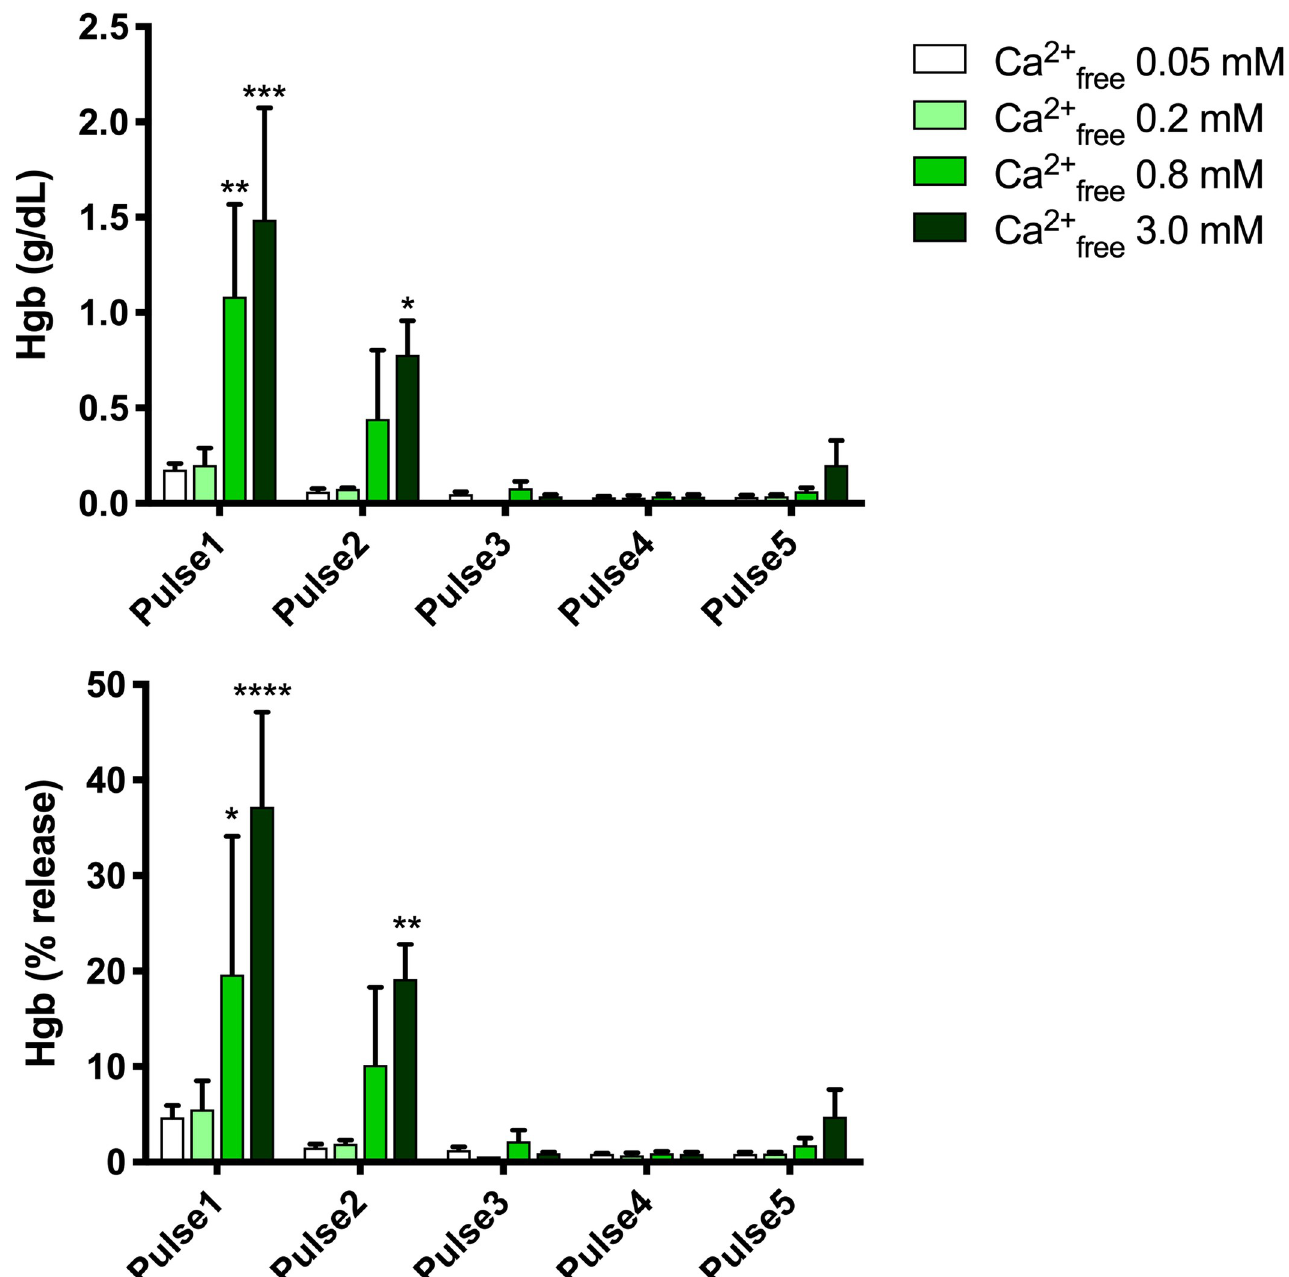
Fig 2. Hemoglobin in supernatants of electrical activated samples. Upper panel, g/dL, lower panel, % of total hemoglobin. Results are means ± SEM, n = 3. Asterisks indicate significant differences within each pulse treatment for 0.2, 0.8 and 3.0 mM Ca 2+ free vs. 0.05 Ca 2+ free . � p < 0.05, �� < 0.01, ��� < 0.001, ���� < 0.0001, Tukey’s multiple comparisons test adjusted for